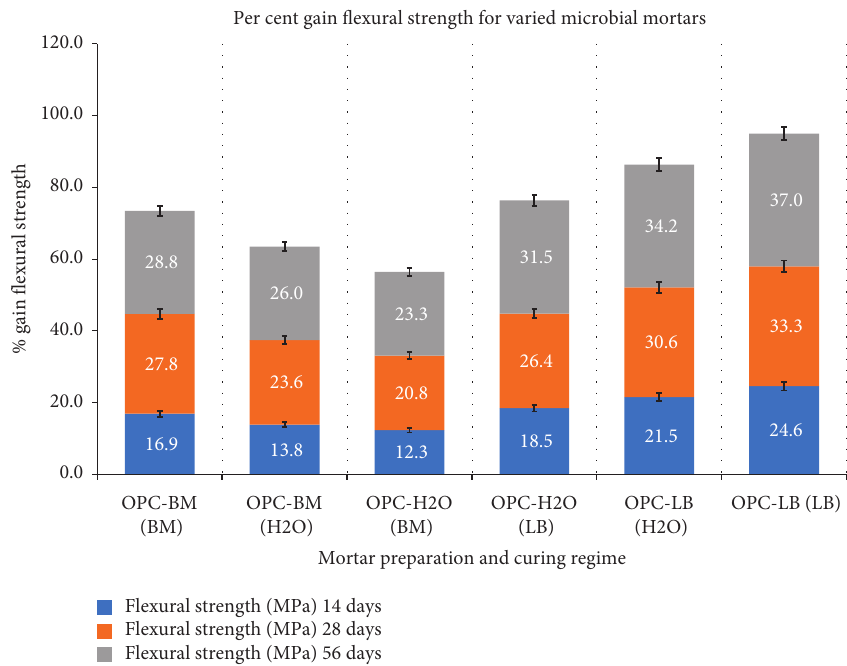
Figure 6: Percent gain flexural strength of test mortars at 14 th , 28 th , and 56 th day of curing.